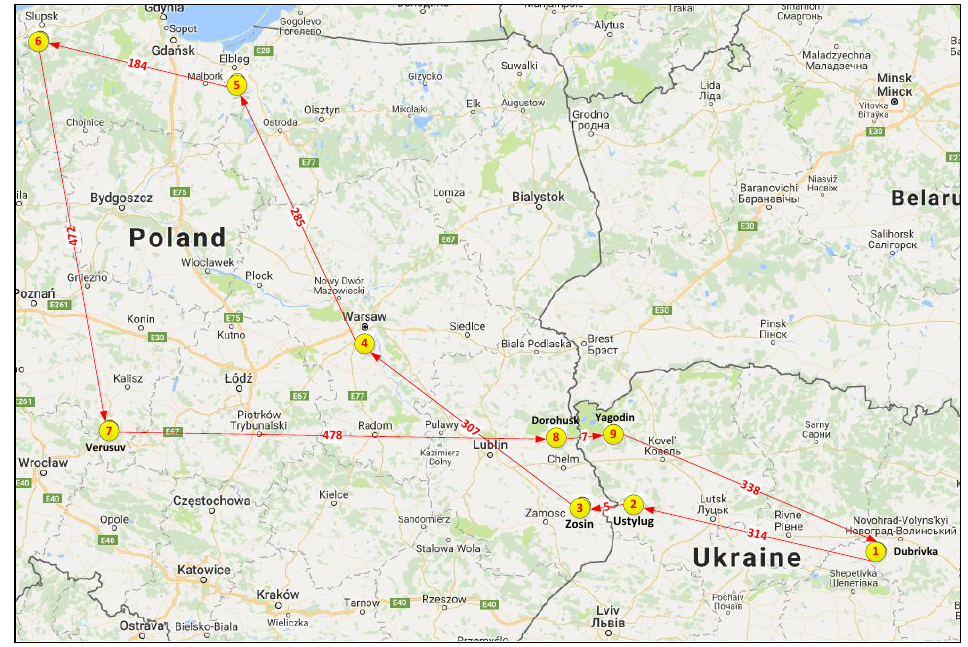
Figure 5: Map of a defined closed